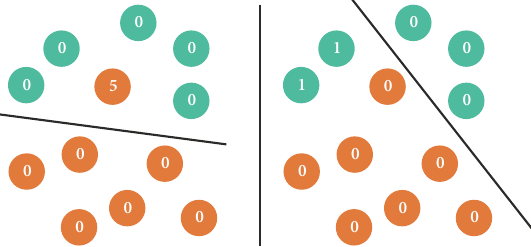
Figure 1. The result of a cost-insensitive classifier (left); the result of a cost-sensitive classifier